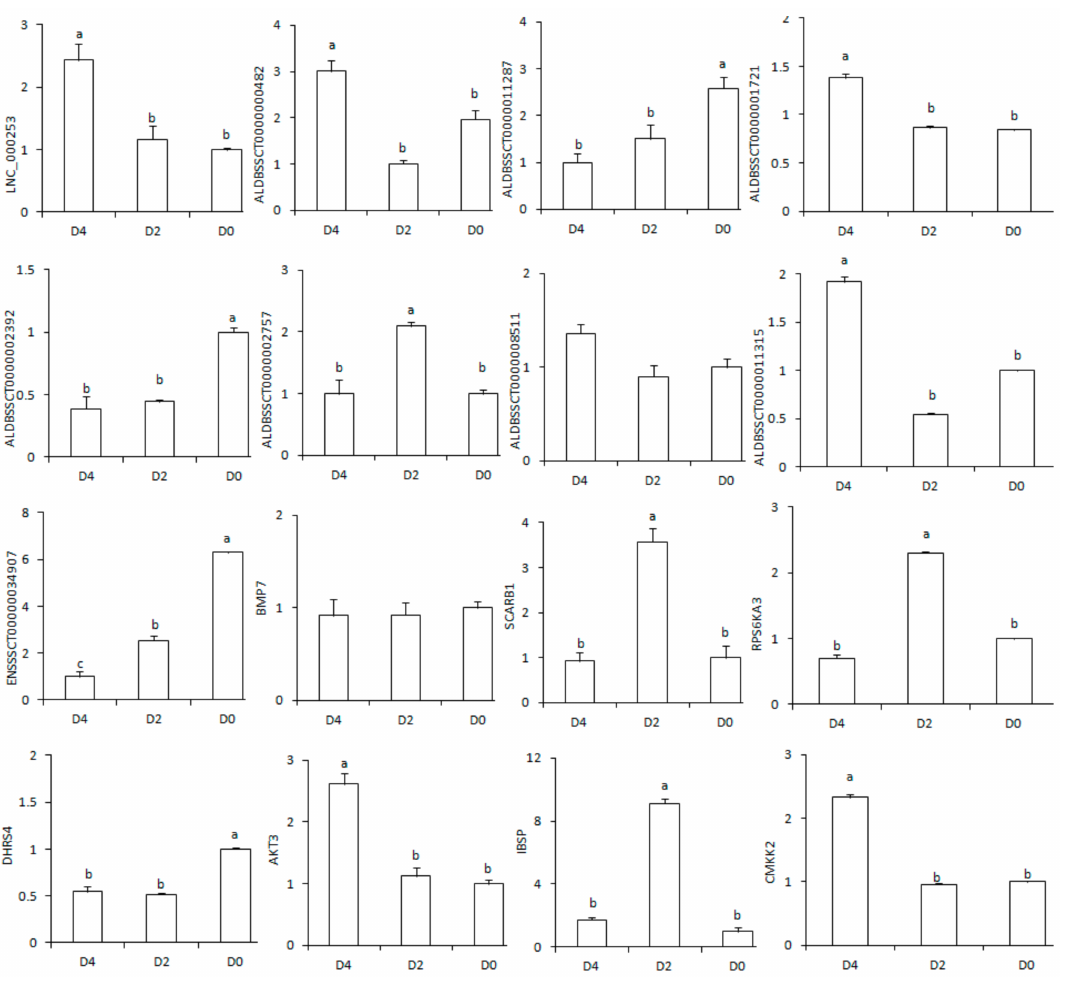
Figure 3. Confirmation of the expression patterns of lncRNA and mRNA using qRT-PCR. Nine random differentially expressed lncRNAs and seven mRNAs from the three compared groups were analyzed by qRT-PCR. Transcript expression was quantified relative to the expression level of GAPDH using the comparative cycle threshold ( − ∆∆ C t ) method. The column height represents the fold change compared with the control sample. Different superscript letters between columns indicate a significant difference ( p <